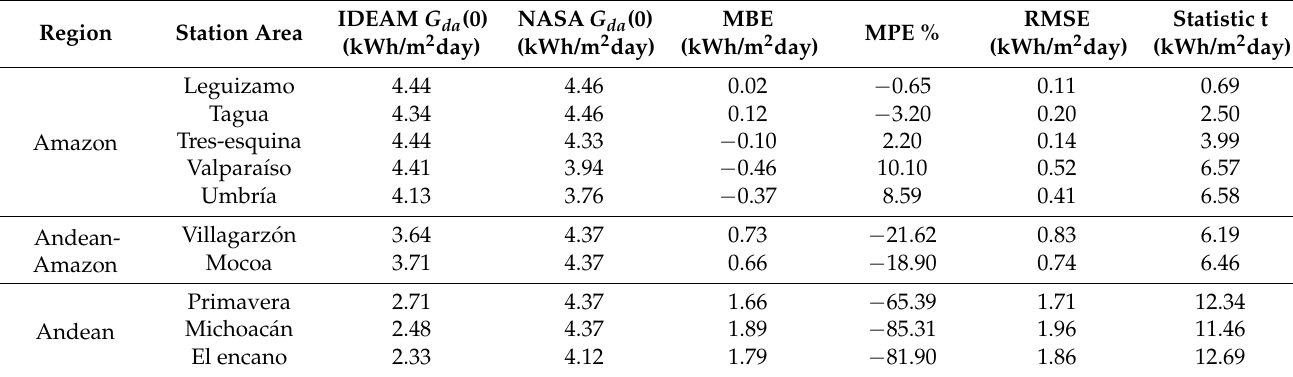
Table 4. Comparison of irradiation values G da from IDEAM weather stations and NASA remote sensor data.